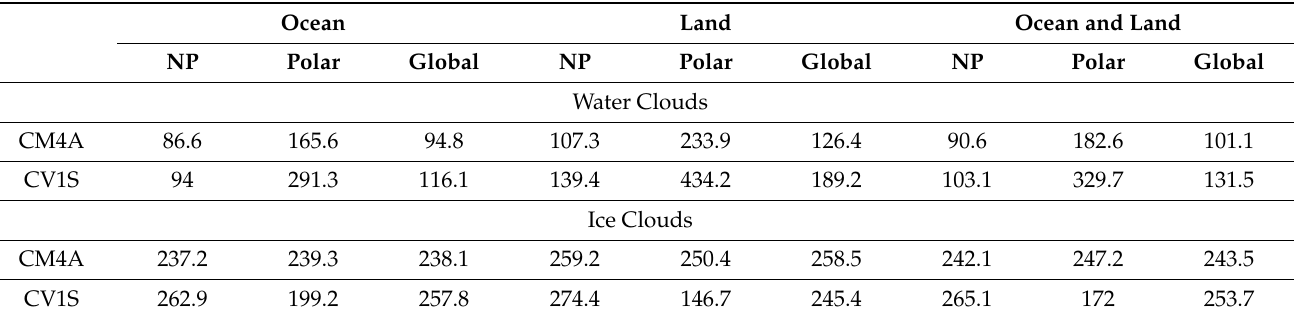
Table 7. Same as Table 2, except for the daytime mean liquid and ice cloud water path (gm − 2 ) over cloudy areas